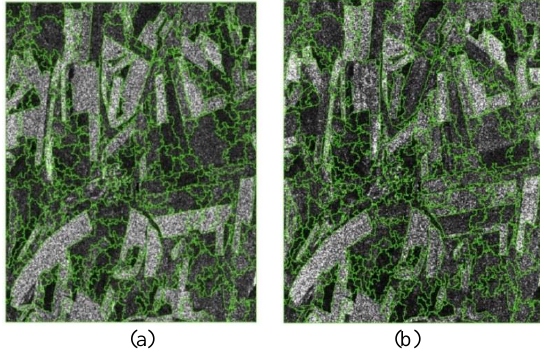
Figure 4. Results of PolSAR images segmentation, (a) Image 1, (b) Image 2